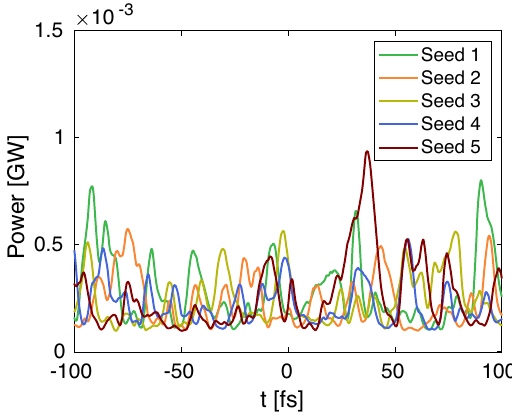
FIG. 7. SASE background in temporal domain for the five initial shot noise cases studied in this